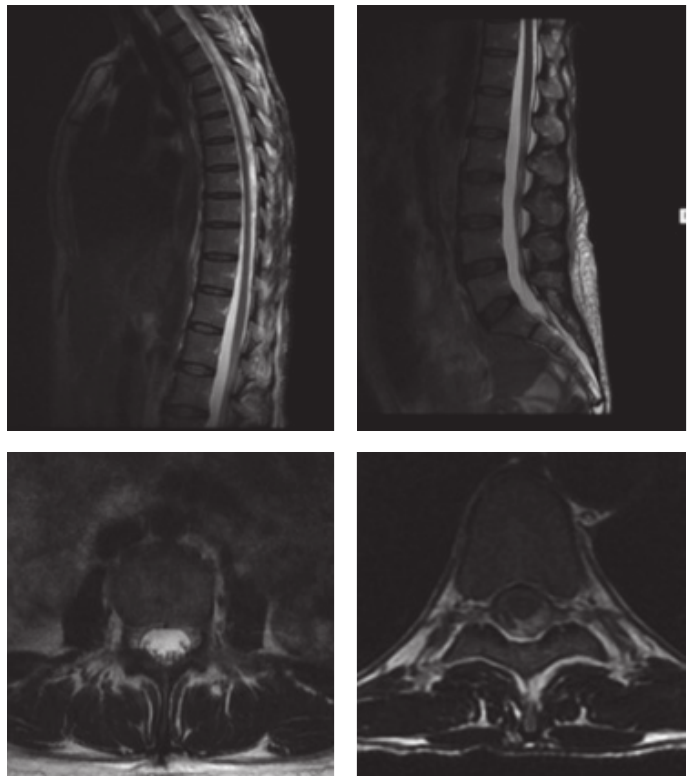
Figure 2: Sagittal and axial T2 weighted MRI images. Vertebral height, disc height, alignment, and bone marrow signal are within normal limits. The canal and neural exit foramina are capacious at all